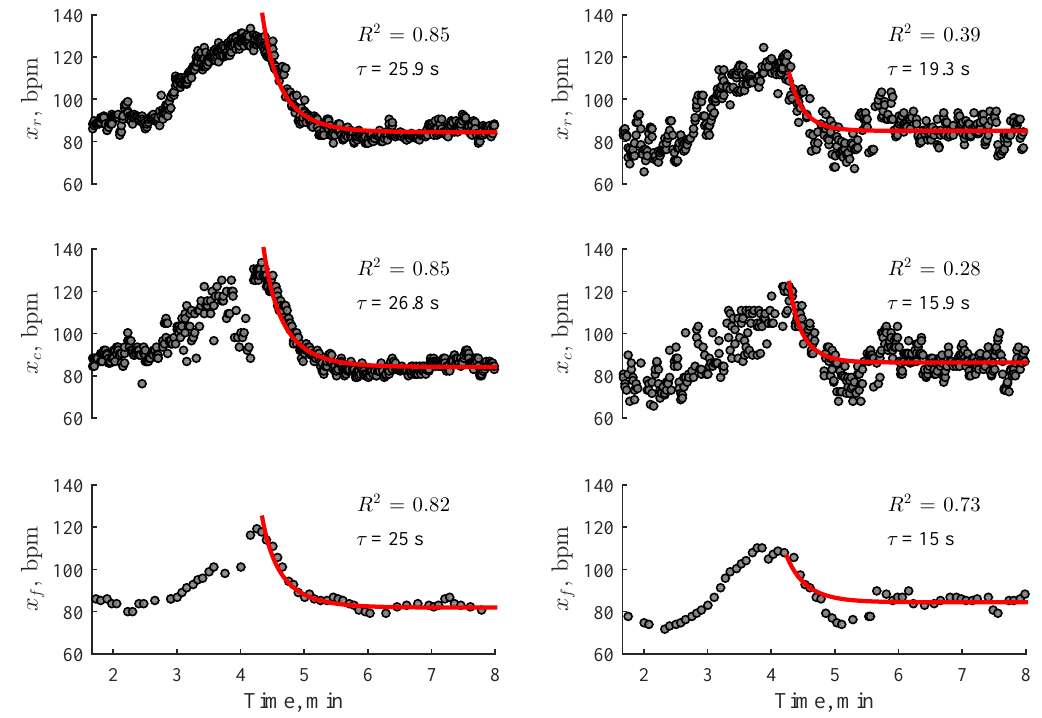
Figure 4. Examples of exponential fitting to heart rate series after the stair climbing activity. Slower recovery results in larger R 2 values (left column), whereas faster recovery increases heart rate variability in the slow recovery phase, and thus, reduces R 2 to such an extent that fitting is considered no longer reliable (right column). Note that R 2 is often larger for heart rate series acquired using smart wristband Fitbit Charge 2 due to processed heart rate series using proprietary algorithms, which artificially reduce